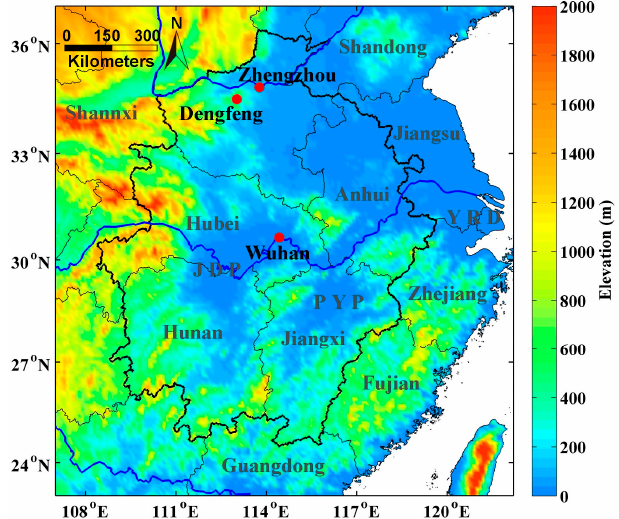
Figure 1. Elevation map of study area. JDP, PYP, and YRD represent the Jianghan and Dongting Plain, Poyang Plain, and Yangtze River Delta, respectively.